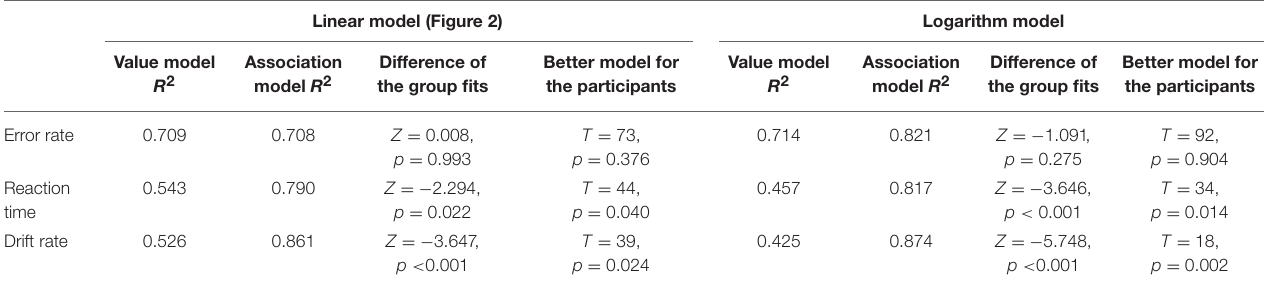
TABLE 2 | Goodness of fit of the models (measured as R 2 ) and comparison of the correlations (Difference column) for the error rates, reaction times, and drift rates patterns based on the group average data, and hypothesis tests for choosing the better model based on the participants’